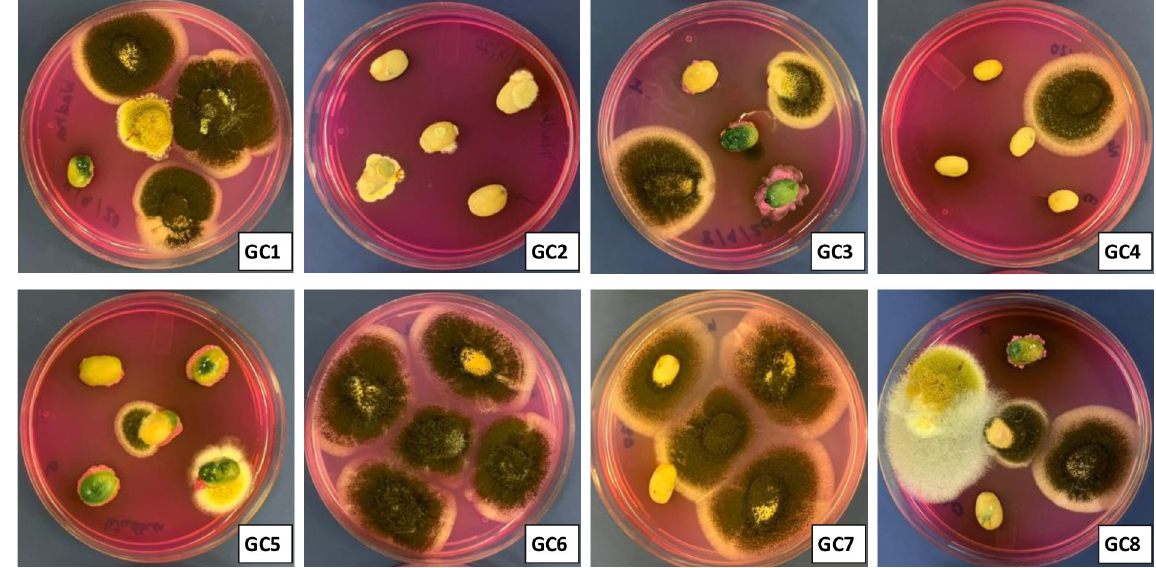
Fig 1. Isolation of fungi on DRBC agar from green coffee (GC) beans samples. Isolation of fungi on Dichloran Rose Bengal Chloramphenicol (DRBC) agar from green coffee (GC) beans samples. All green coffee beans samples yielded fungal communities, while none of roasted and soluble coffee samples showed fungal